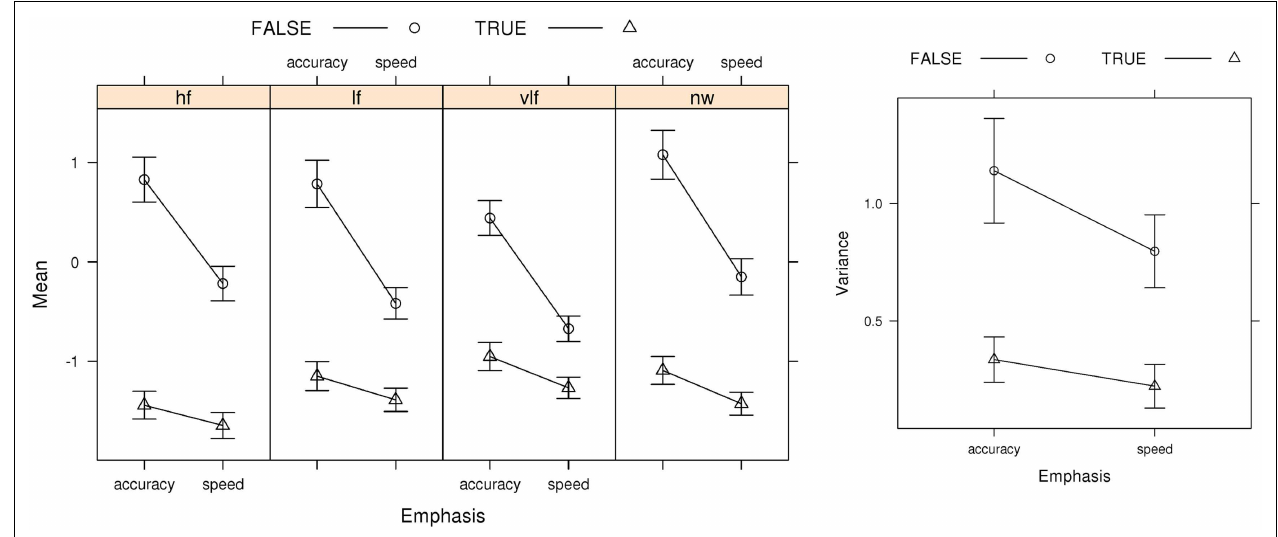
FALSE, error-response accumulator;TRUE, correct-response accumulator; hf, high-frequency words; lf, low-frequency words; vlf, very low-frequency words; nw, non-words.